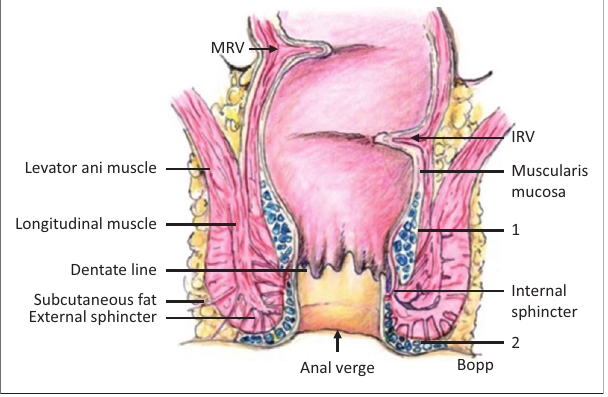
FIGURE 2: Anatomy of rectum: Middle rectal fold of valve of Houston and inferior rectal fold of valve of Houston: 1, submucosal space and internal haemorrhoidal plexus; 2, external haemorrhoidal plexus in peri-anal space.